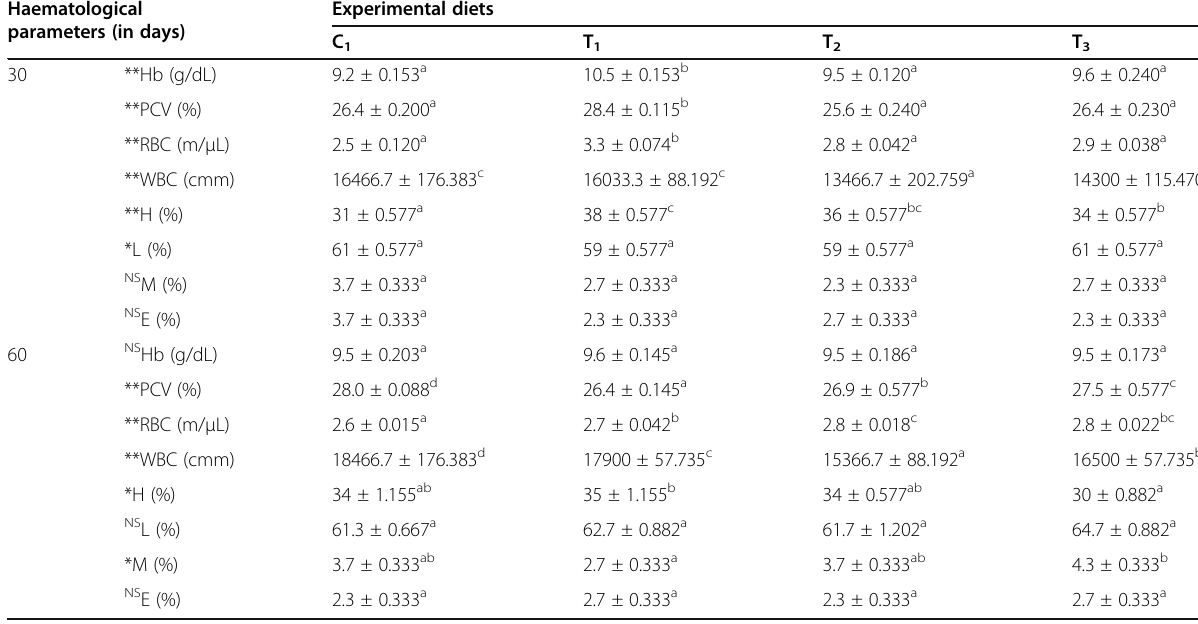
Table 5 Effect of seaweed ( Ulva lactuca ) and Azolla feed supplement on haematological parameters of Aseel chicken Haematological parameters (in